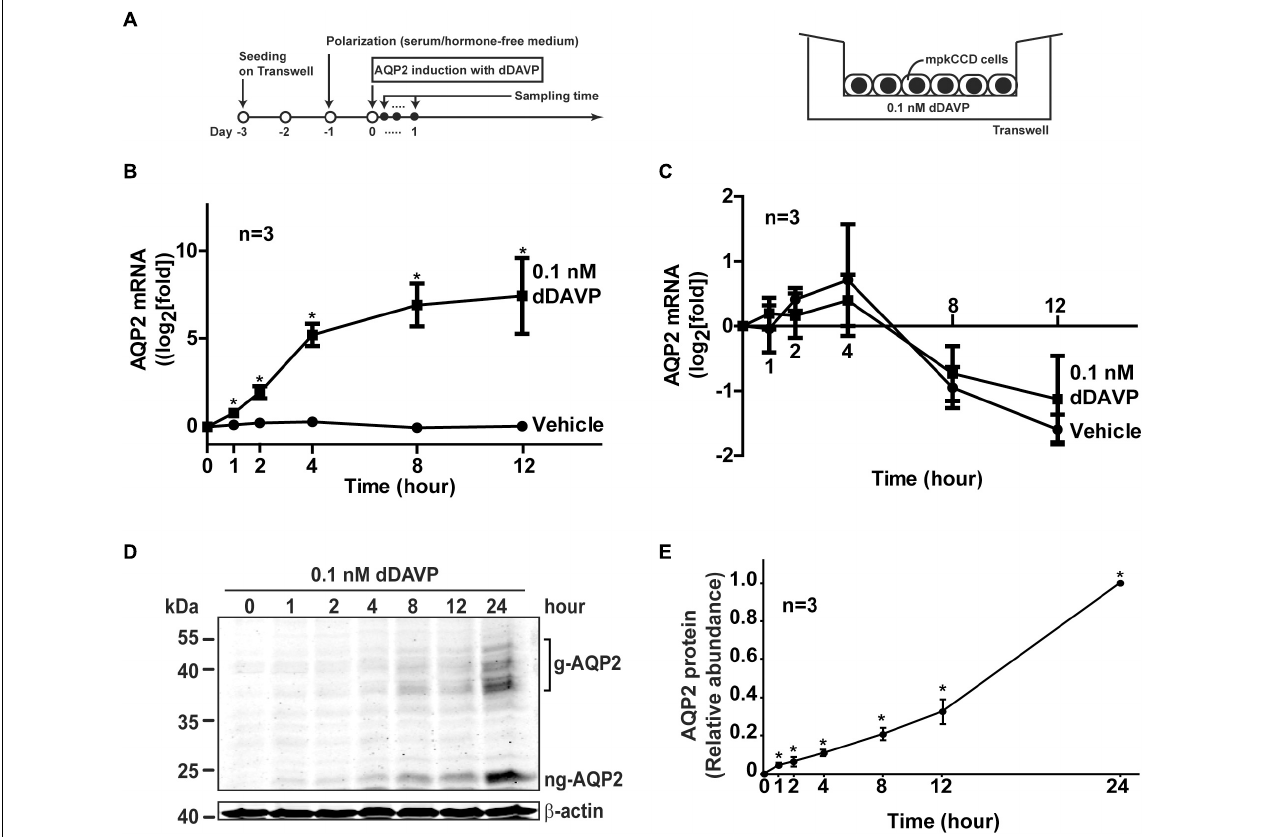
FIGURE 1 | Vasopressin increased AQP2 gene expression in the mpkCCD cells. (A) The experimental protocol for cell polarization and endogenous AQP2 induction. (B) Time-course quantitative real time PCR measurements of AQP2 mRNA in the mpkCCD cells exposed to vehicle or vasopressin analog (0.1 nM dDAVP). Values are means ± SE, adjusted for loading with the RPLP0 mRNA levels and normalized against the values at time zero. Asterisk indicates significance ( p < 0.05, t -test) against the values of the vehicle-treated cells at the same time point. (C) Time-course measurements of AQP2 mRNA in the mpkCCD cells in the presence of actinomycin D. Polarized mpkCCD cells were induced to express AQP2 mRNA (24 h). The cells were then treated with actinomycin D (2 µ M) in the absence or presence of dDAVP for the indicated time before the AQP2 mRNA measurements. (D,E) Representative and summary of immunoblotting for AQP2 protein in the mpkCCD cells in response to dDAVP. Values are means ± SE, adjusted for loading with β -actin levels and normalized against the values at 24 h. Asterisk indicates significance ( p < 0.05, t -test) against the values at 0 h. Two-way ANOVA was used to assess time-dependent effects of dDAVP vs. vehicle treatment. Respectively, g-AQP2 and ng-AQP2 indicate glycosylated and non-glycosylated